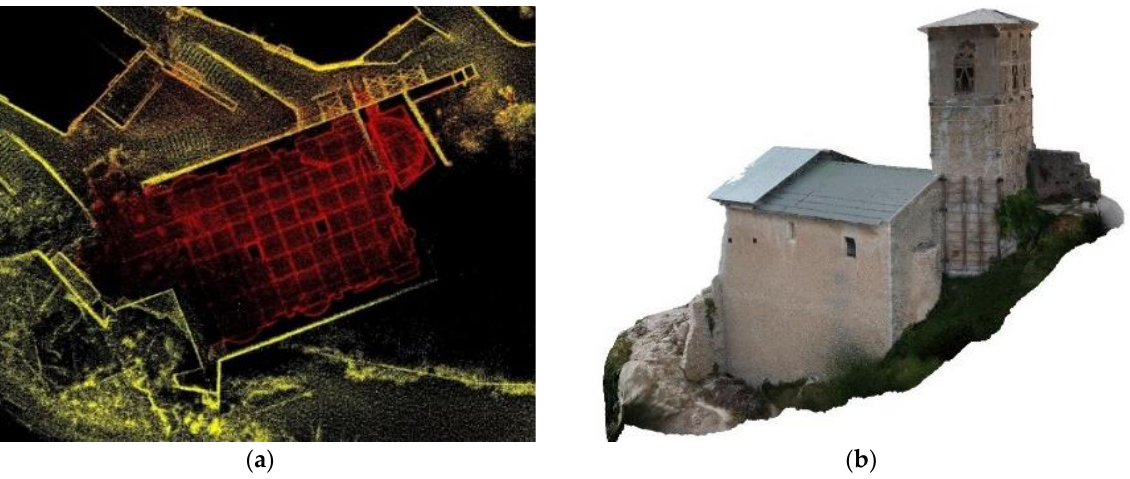
Figure 4. ( a ) Integration in planar view of indoor point cloud from mobile laser scanner (red) with outdoor point cloud from mobile scanner and UAV photogrammetry; and ( b ) textured 3D mesh model from UAV images data.